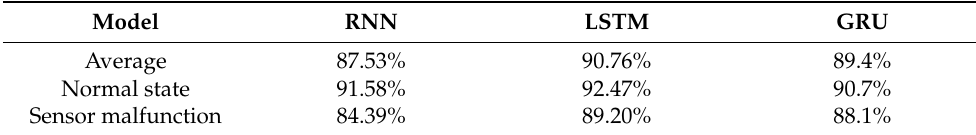
Table 3. Fault classification accuracy of different algorithm.